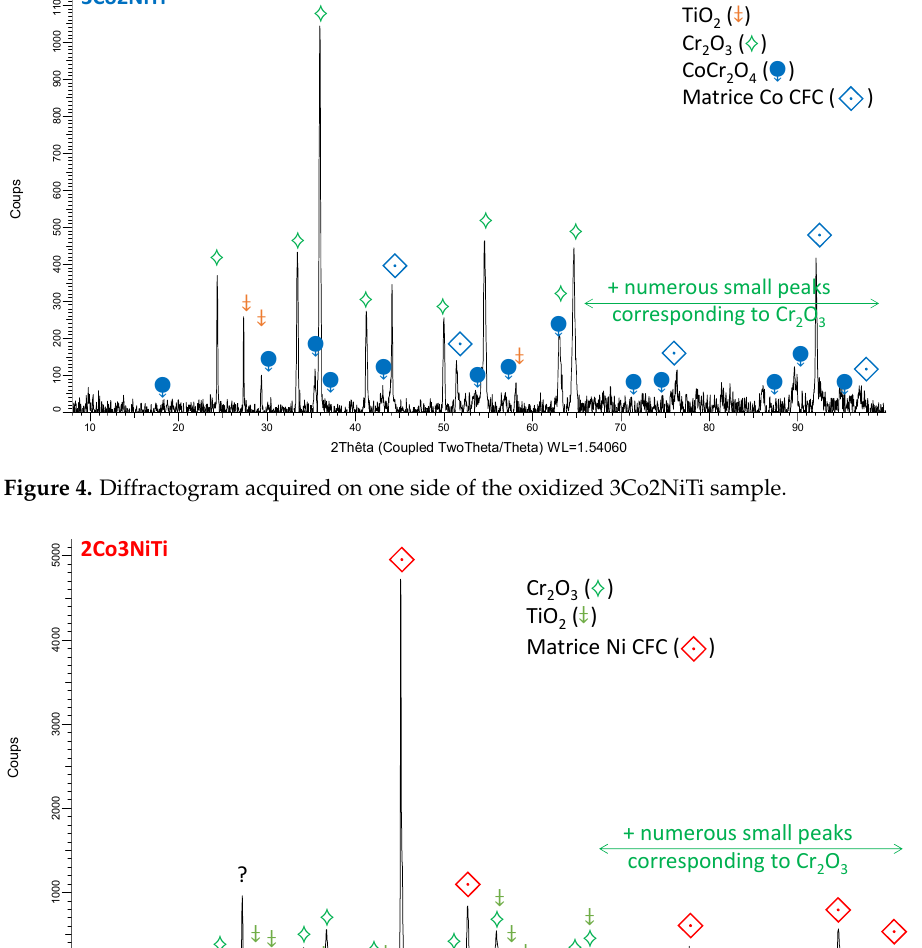
Figure 6. Diffractogram acquired on one side of the oxidized 0Co5NiTi sample. Chromia (Cr 2 O 3 ) is present on the surface of all the oxidized samples. However, one must also notice the presence of the titanium oxide TiO 2 for all the alloys. Cobalt oxides (CoO) and the spinel involving cobalt and chromium (CoCr 2 O 4 ) are also noticed, but only for the Co-richest alloys. The Ni-richest alloys, after oxidation, are all free of these oxides involving cobalt. XRD only detected the Cr 2 O 3 and TiO 2 oxides. One must also note that the diffraction peaks corresponding to the matrixes of the alloys are systematically found in the diffractograms: they are the contributions of the zones denuded by oxide spallation. After gold deposition, the oxidized samples, with now good electrical conductivity on the surface, were studied using the SEM and by X-ray cartography. Two examples given in Figure 7 for the Co-rich alloys (represented by the 3Co2NiTi alloy) and in Figure 8 for the Ni-rich (represented by the 2Co3NiTi alloy) allow distinguishing the spinel ox- ides involving cobalt, chromia, TiO 2 and zones of the alloy’s surface denuded by oxide spallation.